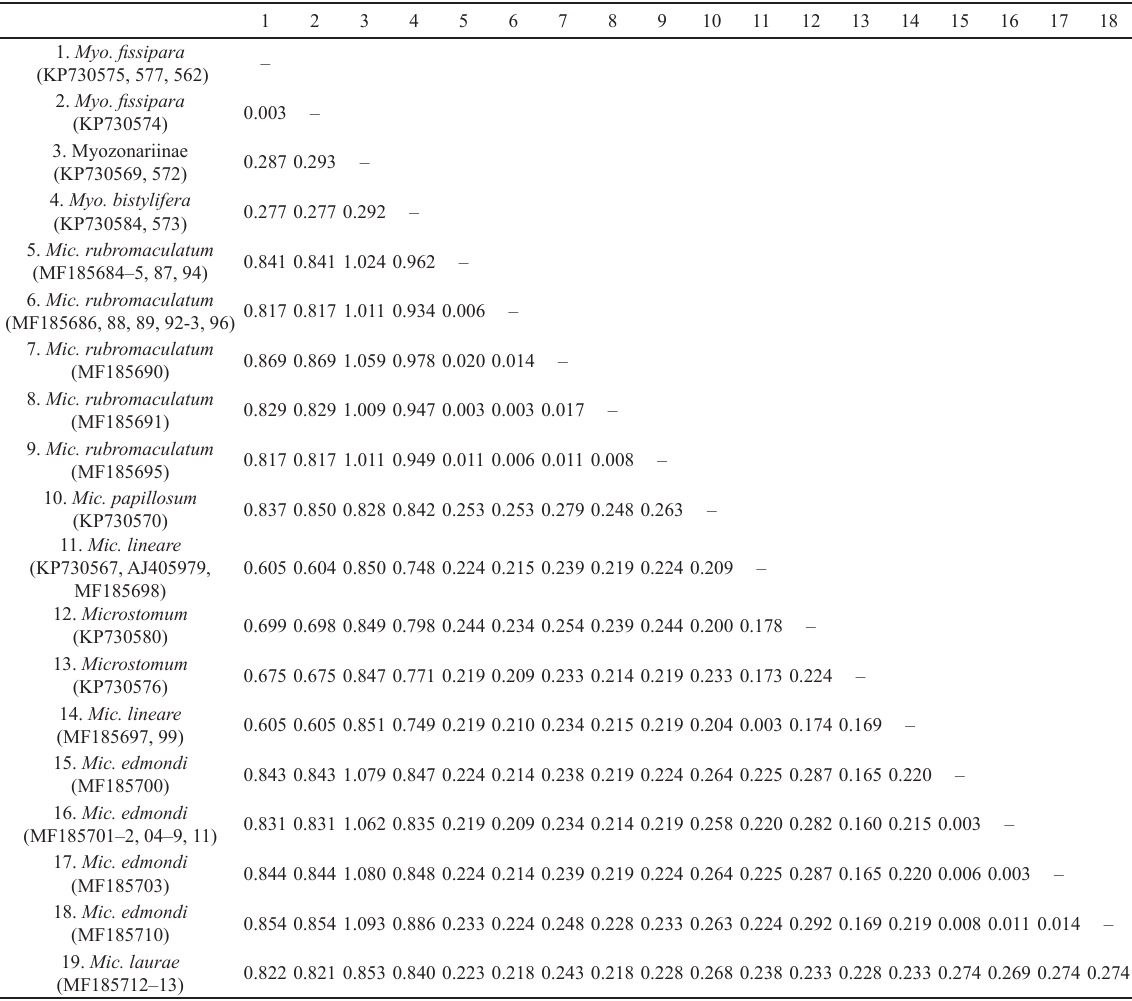
Table 2. Patristic distances between DNA sequences used in this study. Distances were calculated using the TN93-model (Tamura & Nei 1993) with rate variation among sites and gamma distribution. Alignment gaps and ambiguous sites were not considered. Accession numbers are given after species name. Specimens with identical sequences are listed